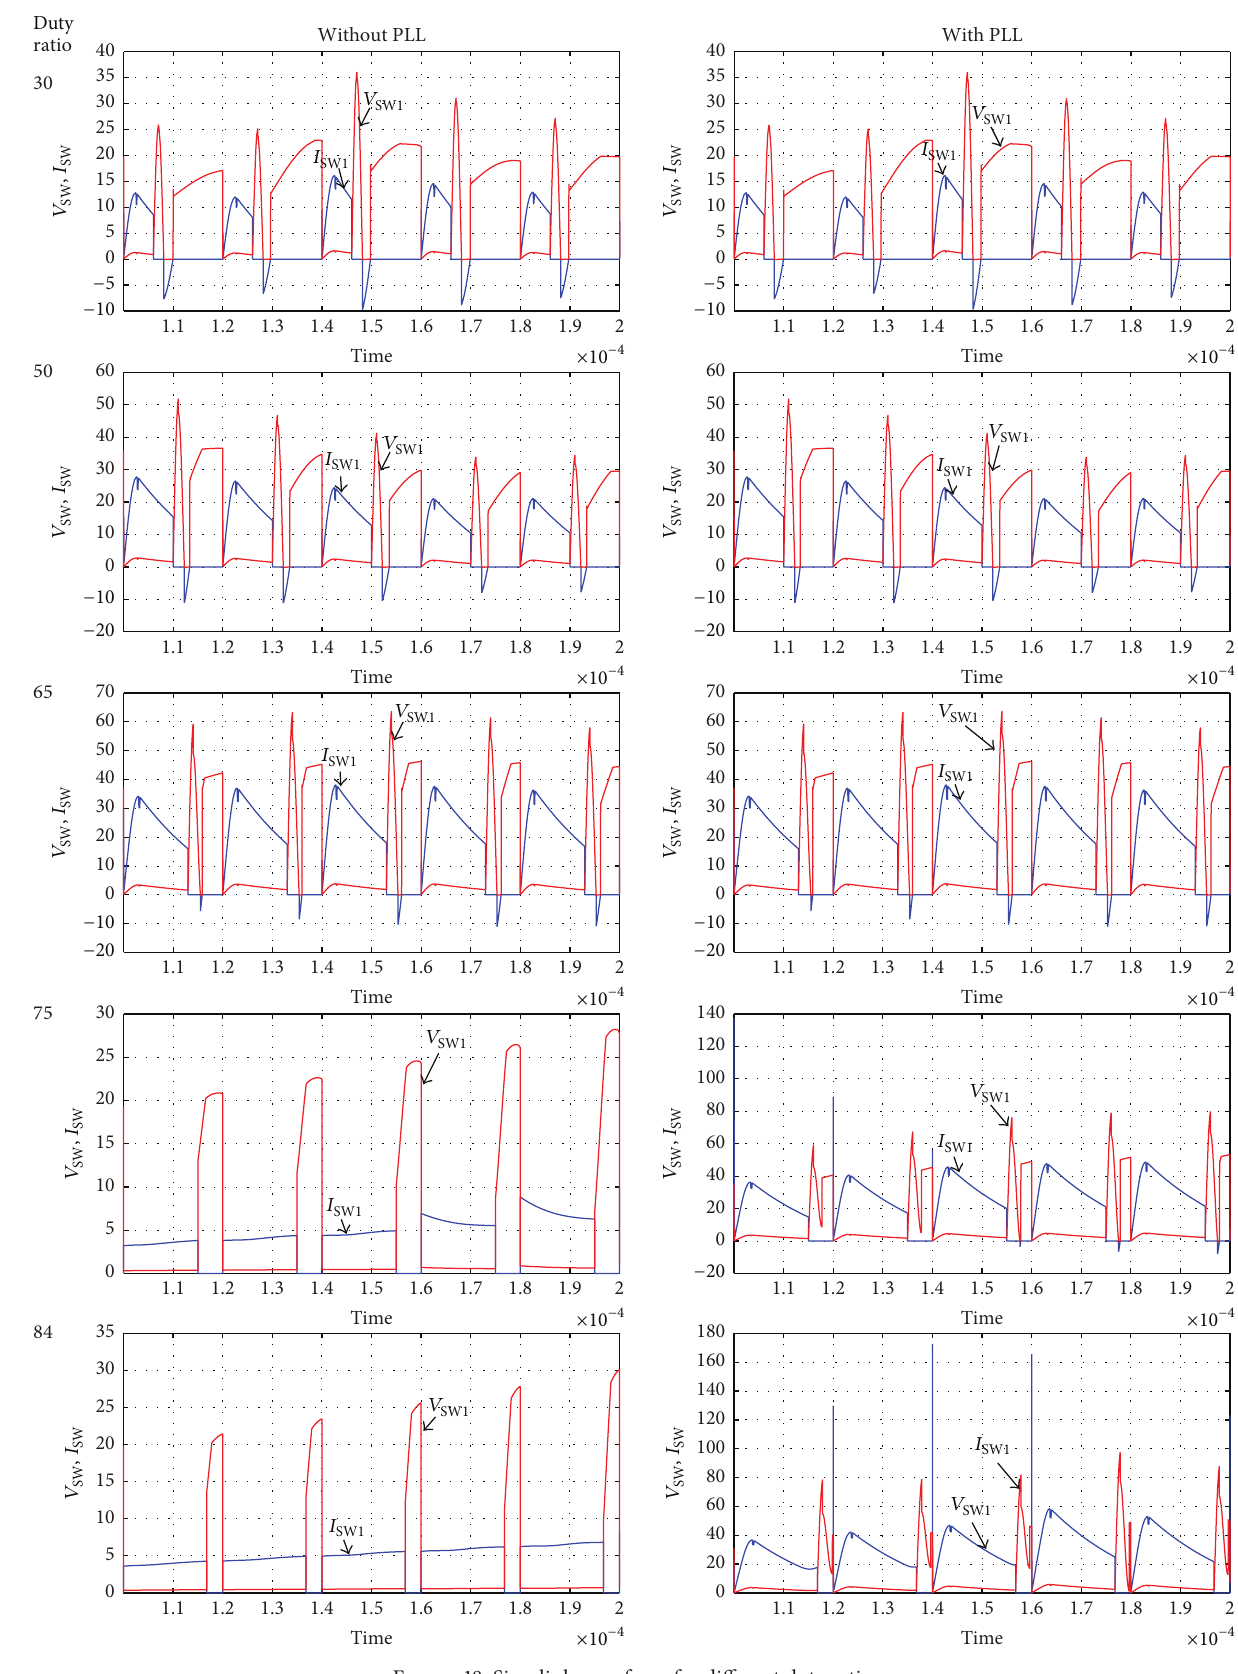
Figure 18: Simulink waveform for different duty